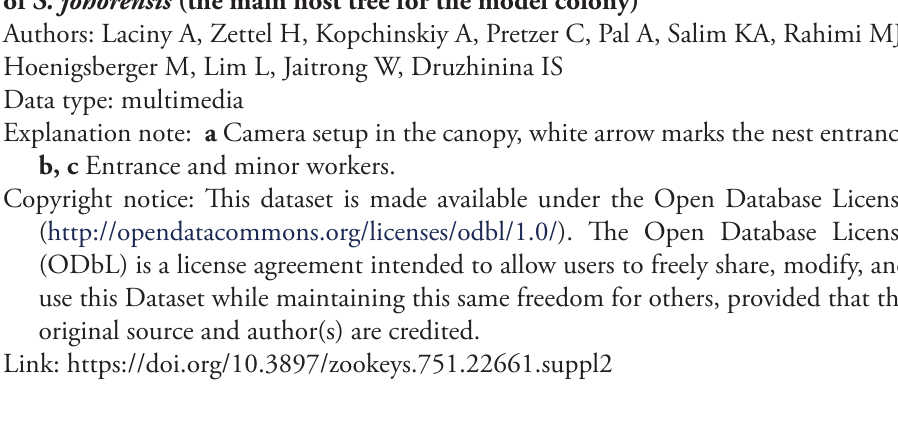
Figure S2. Natural nest of C. explodens sp. n. in a dead branch in the high canopy